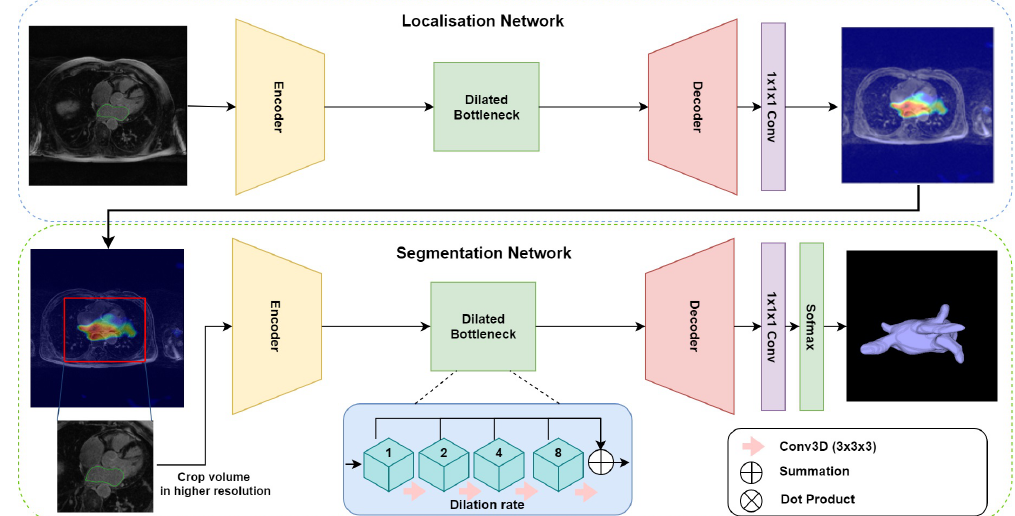
Figure 1. Overall pipeline for the proposed multi-stage network architecture, which depicts an example late gadolinium-enhanced (LGE)-MRI scan with its corresponding intermediate GCAM result. Both encoder–decoder networks used for localisation and segmentation have similar